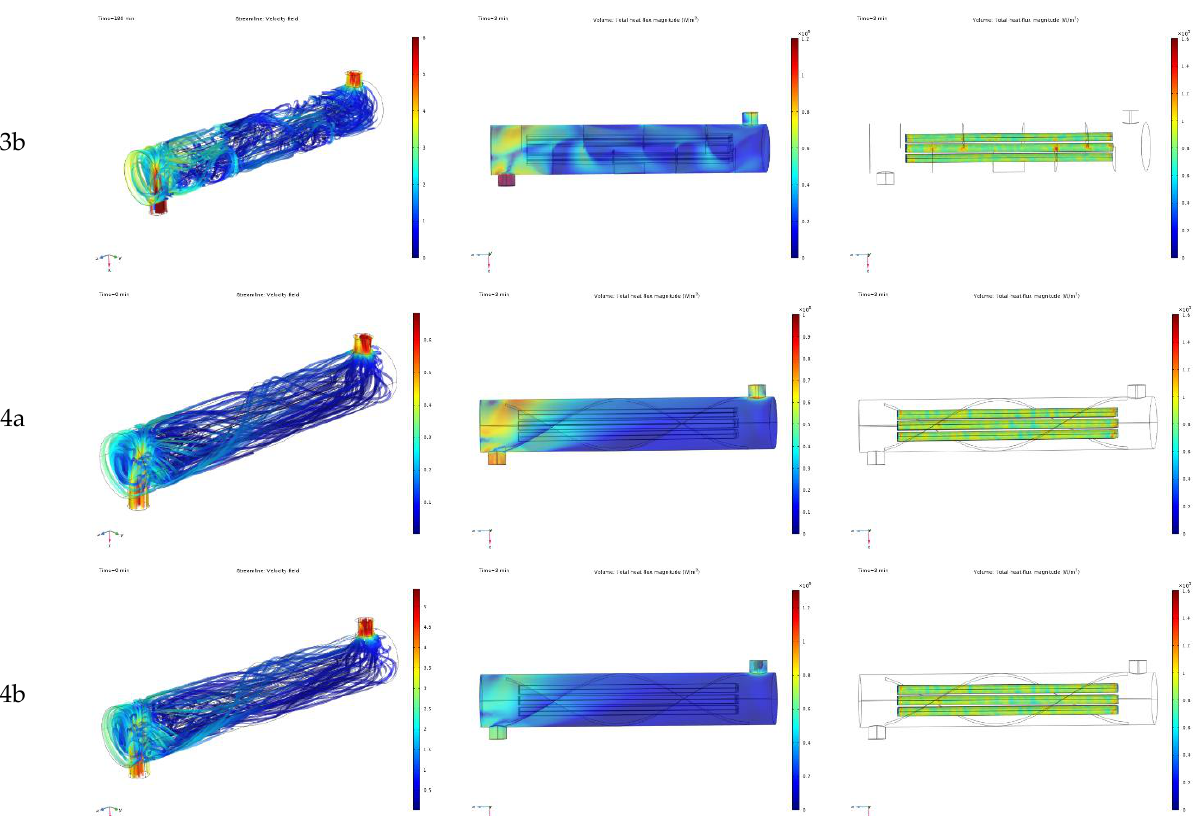
Figure 12. Flow pattern (left column), heat flux in heat transfer fluid (middle column) and heat flux for PCM (right column) for all geometry variants (M1, M2, M3, M4) and two HTF flow velocity values: 1 m/s (a), 4 m/s (b).